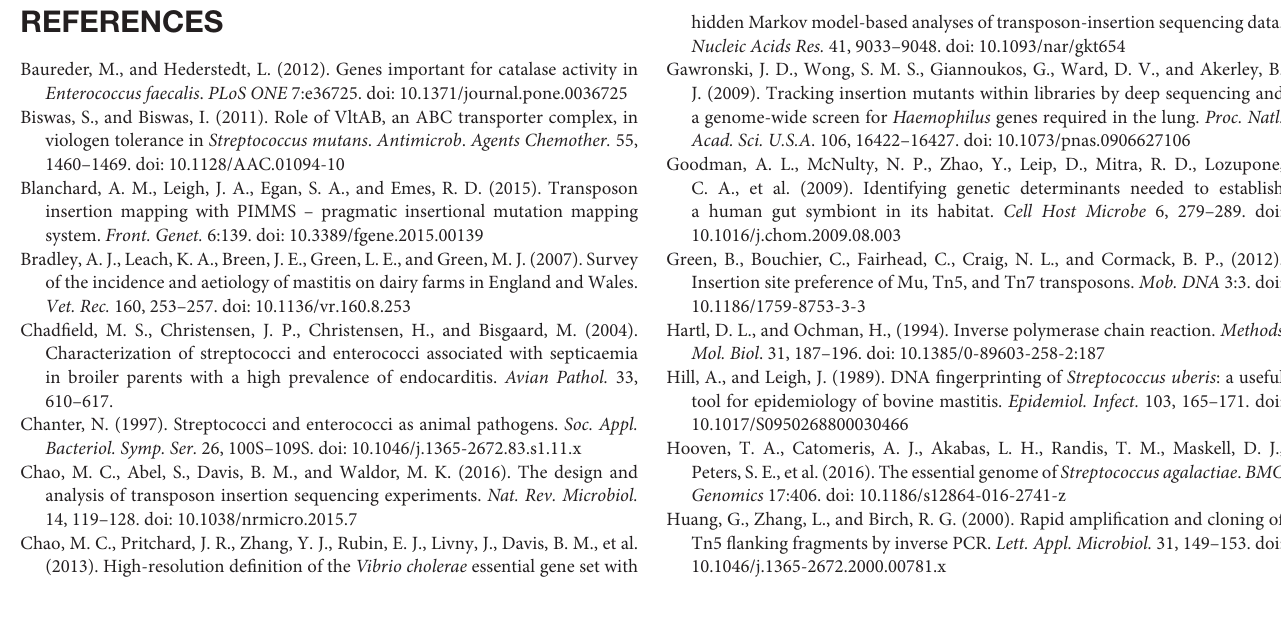
TABLE S1 | Mapped insertion data for each coding sequence in the genome of S. uberis 0140J using PIMMS libraries generated with HindIII , EcoR1 , acoustic shearing (Covaris), no treatment (gDNA); summarized in Table 1. Mapped insertion data for each coding sequence in the genome